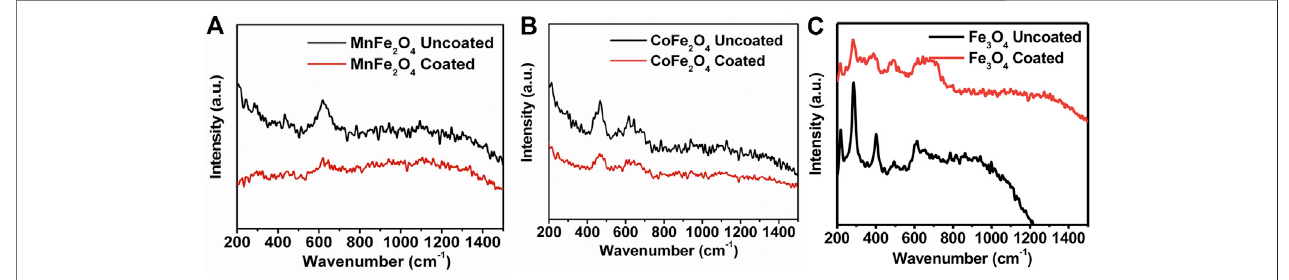
FIGURE 7 | Raman spectra of bare (black) and chitosan-coated (red) MnFe 2 O 4 (A) CoFe 2 O 4 (B) and Fe 3 O 4 (C) nanoparticles.